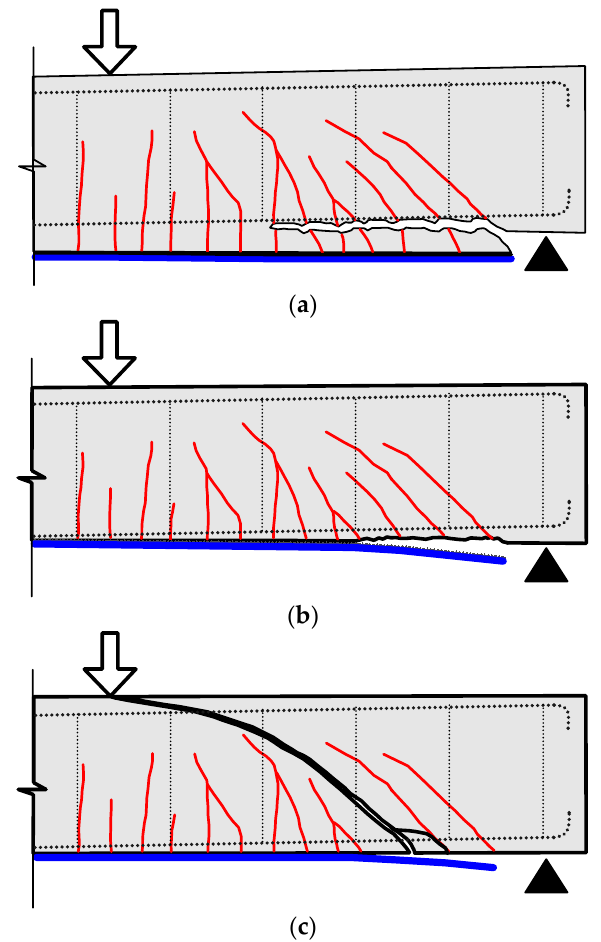
Figure 1. Plate end debonding modes: ( a ) Concrete cover separation; ( b ) Plate end interfacial debonding; ( c ) Critical diagonal crack debonding.